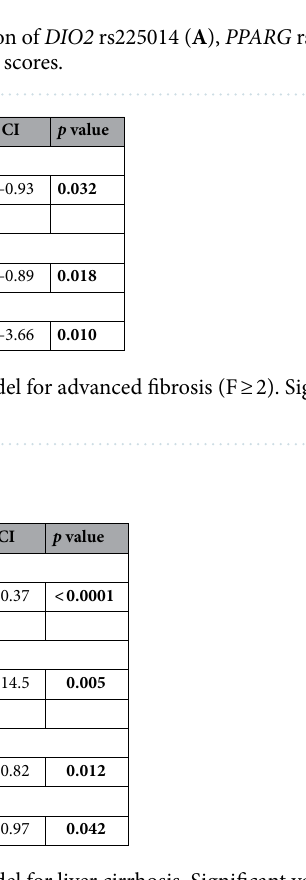
Table 6. Final multiple logistic regression model for liver cirrhosis. Significant values are in bold. CI confidence interval, OR odds ratio, p